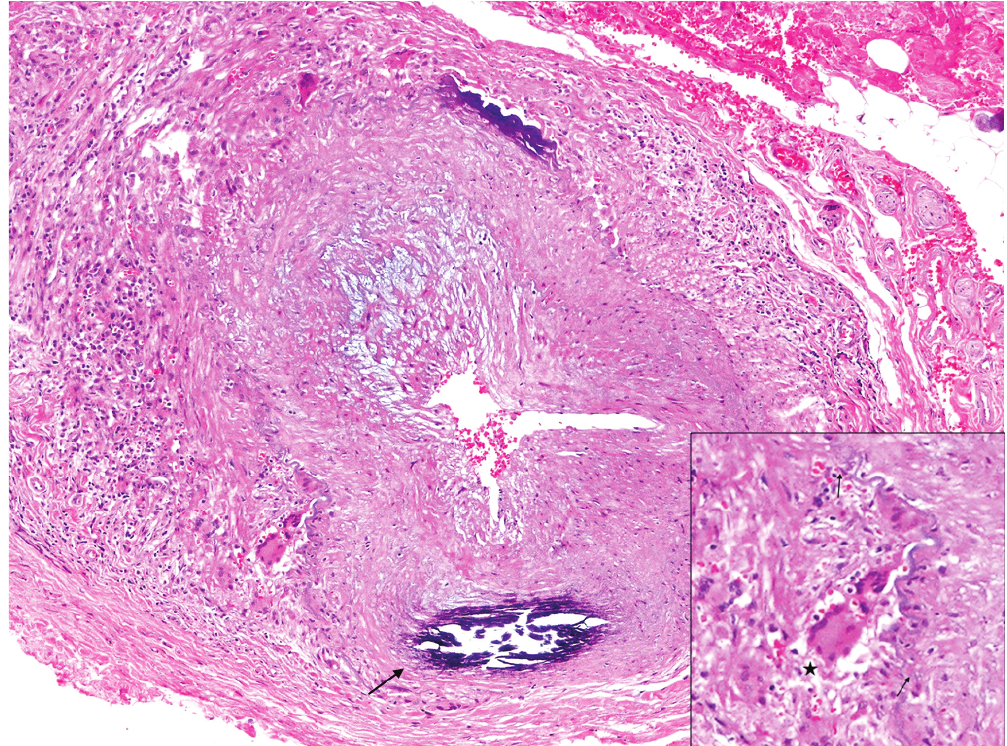
Figure 2. GCA-positive temporal artery biopsy (H&E staining, 100 × magnification). Note the narrowing of the arterial lumen and infiltration of inflammatory cells and multinucleated giant cells (asterisk) in addition to the destruction of the lamina elasticum (short arrows). Age-related intramural calcification is also noted in this specimen (long arrow). GCA, giant cell arteritis; H&E, hematoxylin and